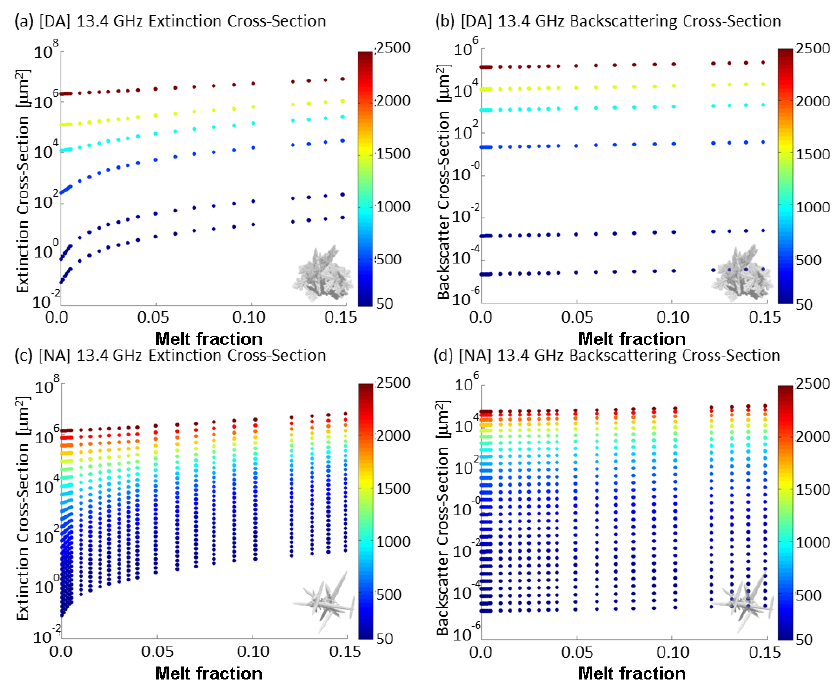
Figure 3. Overview of 13.4GHz extinction and backscattering: dendrite aggregate (row 1) (a) mean extinction cross section vs. melt fraction and (b) mean backscattering cross section vs. melt fraction for various values of effective radius in microns (color bar). Needle aggregate (row 2) (c) mean extinction cross section vs. melt fraction and (d) mean backscattering cross section.